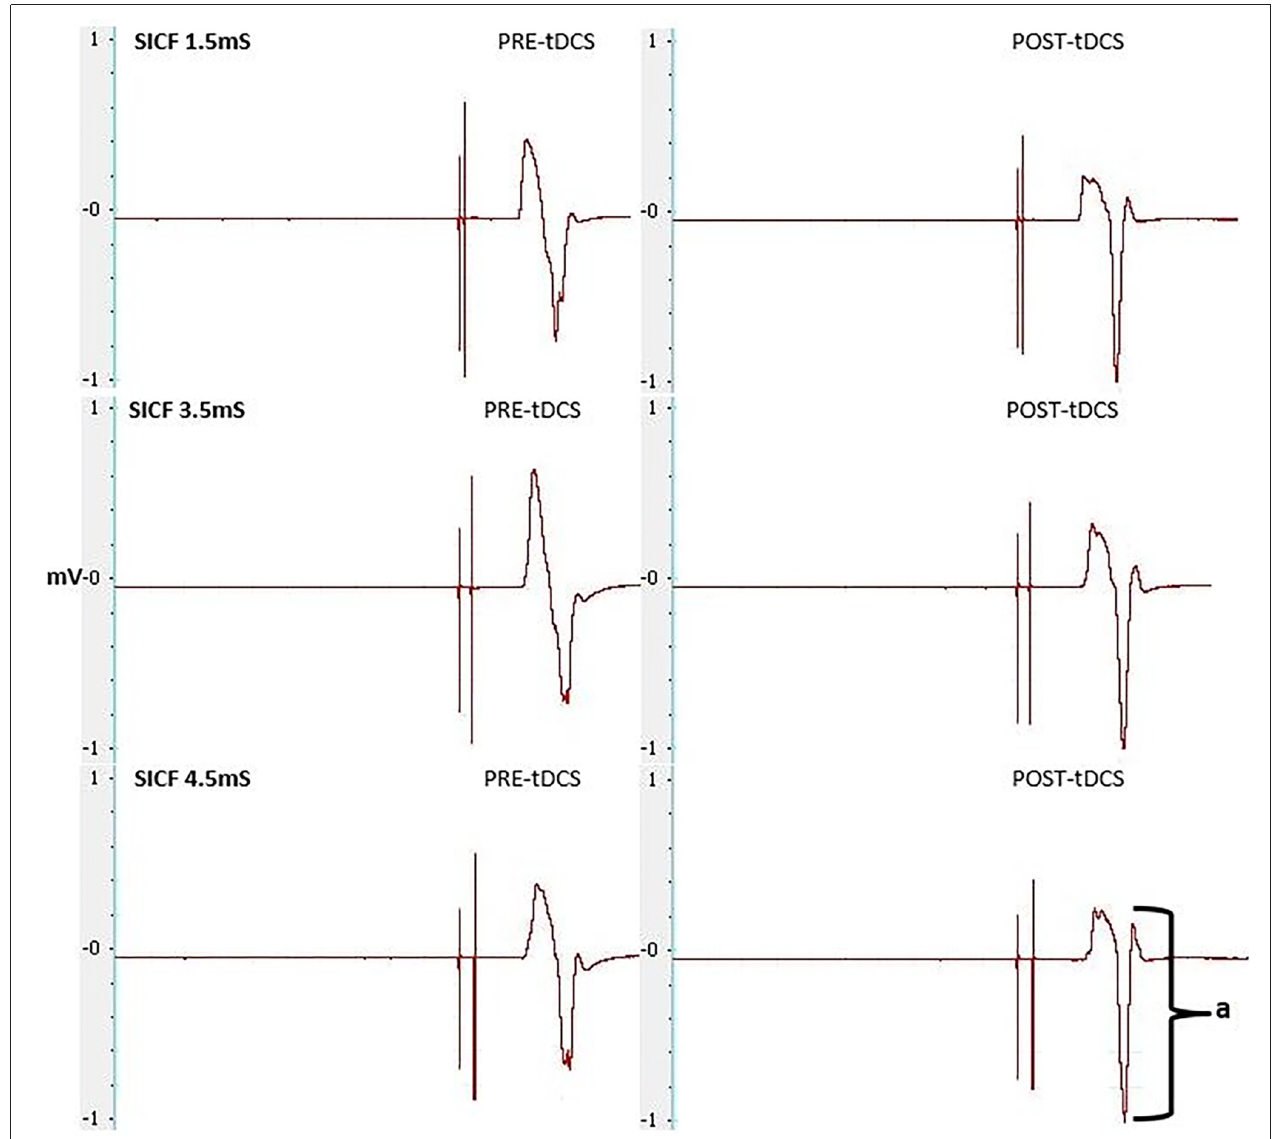
FIGURE 7 | MEPs elicited through SICF at 1.5, 3.5 and 4.5 ms from pre- and post-tDCS in the real condition. a shows the amplitude of the MEP, calculated from peak to peak of the muscle